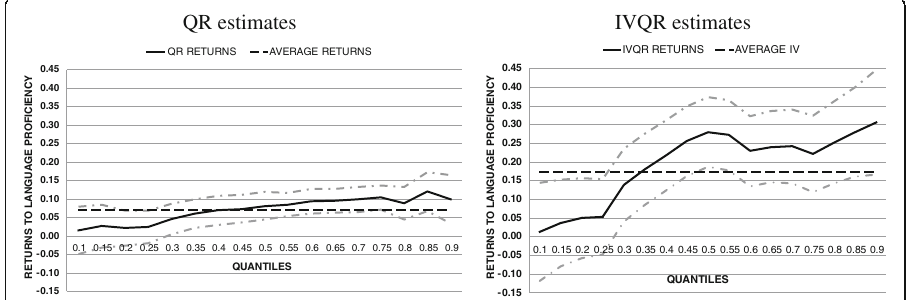
Fig. 1 QR and IVQR estimates — total sample. Note: (i) dotted line in QR returns denotes non-significant at those quintiles, (ii) upper and lower curves comprise the 95% confidence interval, and (iii) models with occupation controls